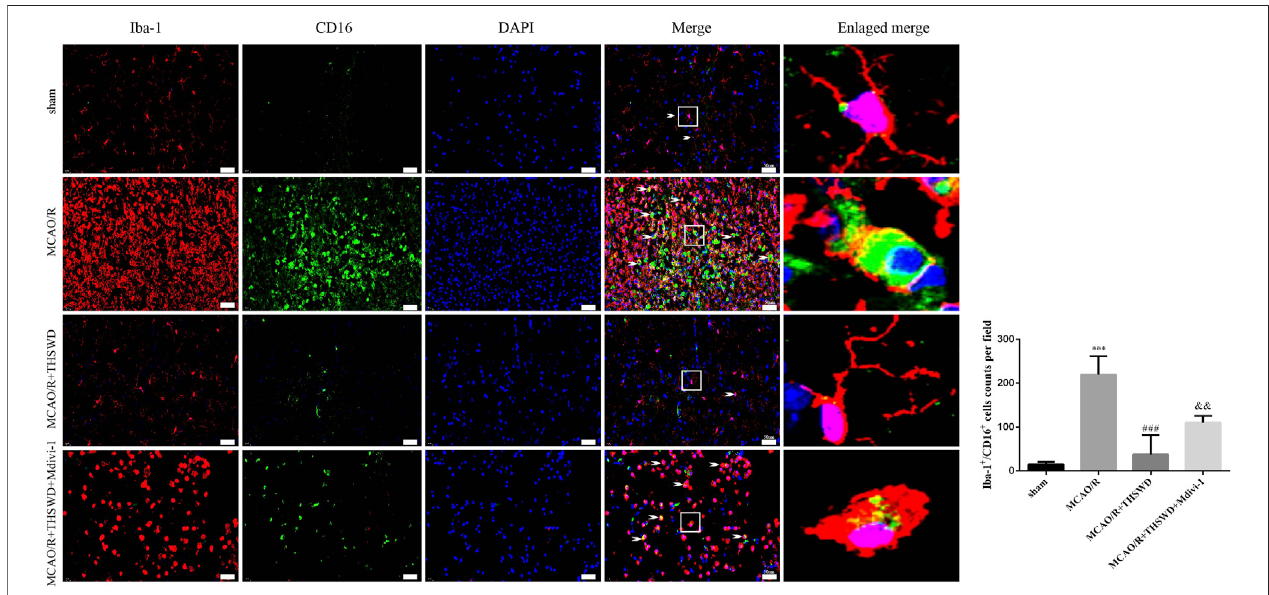
FIGURE6| THSWDtreatmentinhibitsmicrogliaactivation.Microgliaactivationwasobservedbyimmuno fl uorescencedetectionofIba-1/CD16(×400).Scalebar= 50 μ m. Quanti fi cation of Iba-1 + /CD16 + cells counts in the right-hand bar graph. n = 4 per group.*** p < 0.001 versus sham group, ### p < 0.001 versus MCAO/R group, && p < 0.01 versus MCAO/R + THSWD